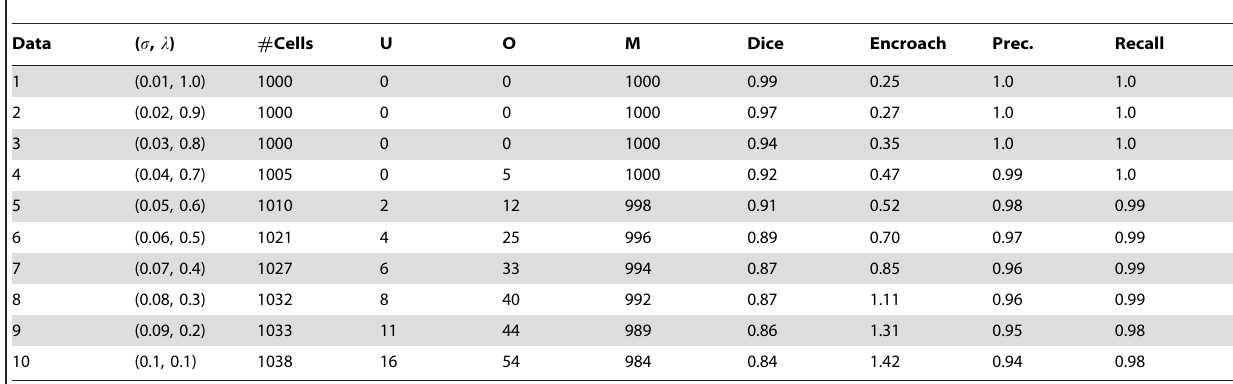
Table 2. High sensitivity in algorithm performance on synthetic data with varying noise parameters.